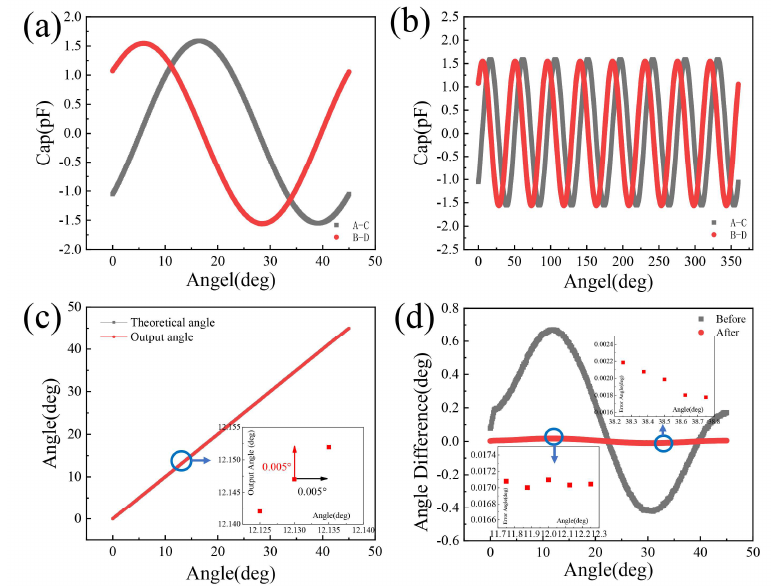
Figure 7. The improved COMSOL simulation results: ( a ) a single cycle of 2π/X (45°); ( b ) curves of C A –C C and C B –C D ; ( c ) improved calculation angle and theoretical angle; and ( d ) the error comparison.